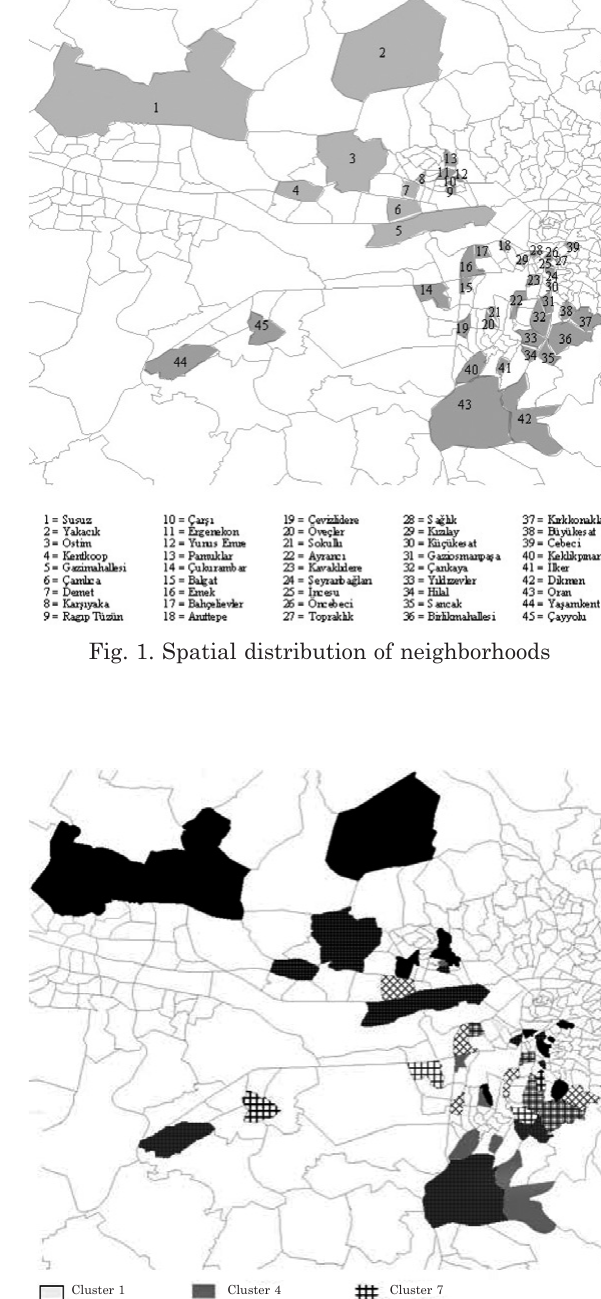
Table 3. Frequencies of clusters